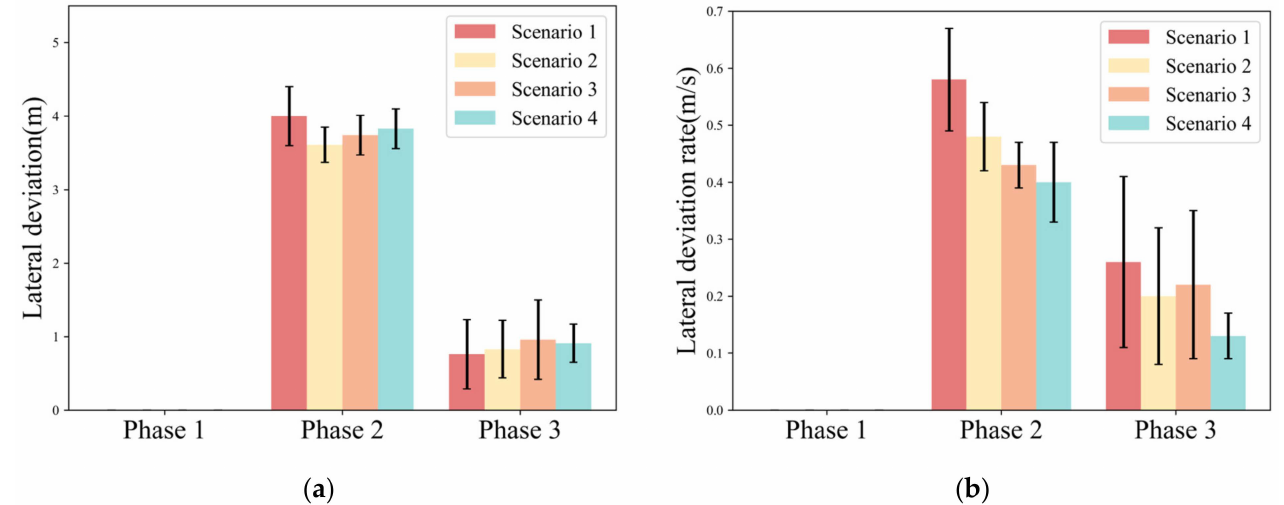
Figure 6. Variation pattern of lateral dynamics parameters. ( a ) Lateral deviation; ( b ) Lateral deviation